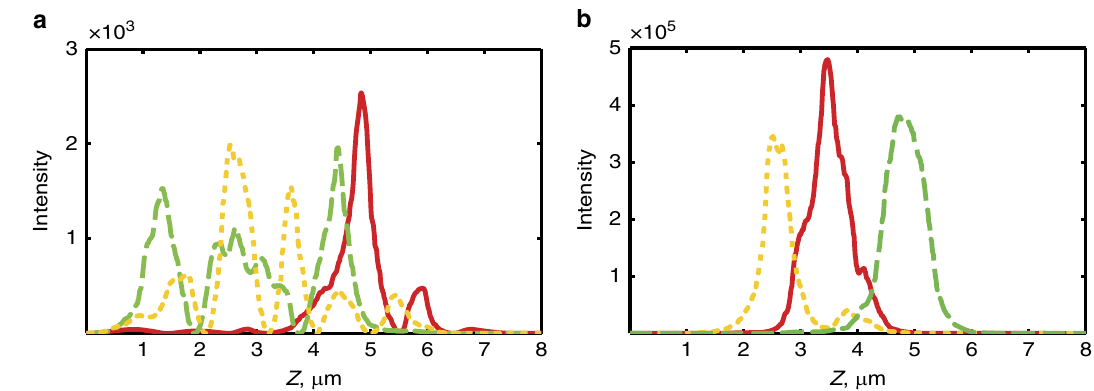
Figure 4 | Typical modes above and below h c . ( a ) Three localized modes for y ¼ 58 (cid:2) and l ¼ 1 m m. These modes were found by considering realizations with high transmission (in an ensemble of 10,000 realizations) and calculating the field distribution. ( b ) Same, for y ¼ 62 (cid:2)